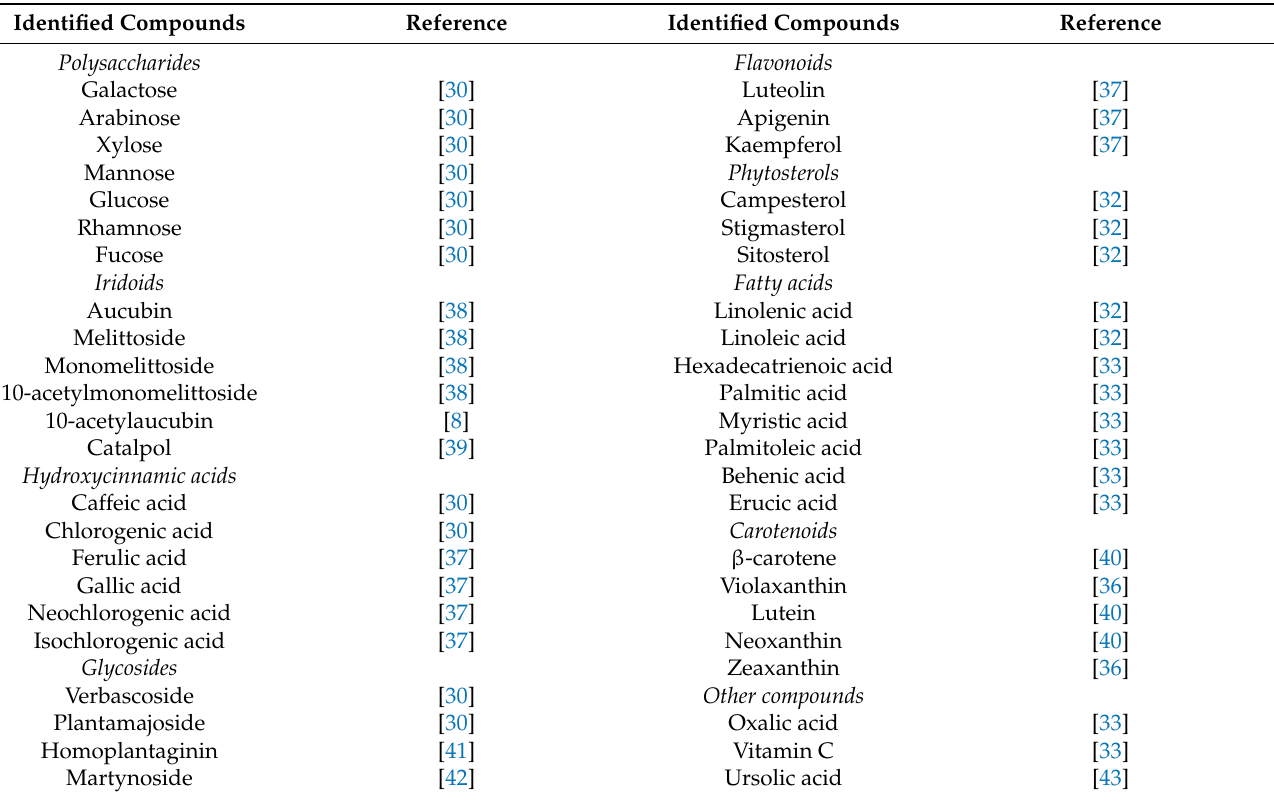
Table 1. General composition of Plantago media L., according to cited literature